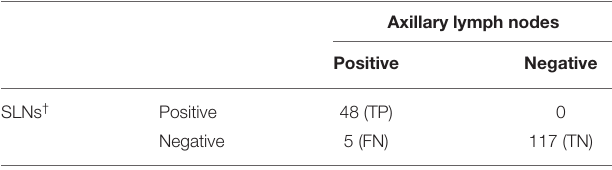
TABLE 2 | Pathologic status of sentinel and axillary lymph nodes in the patients with reSLNB. Axillary lymph nodes Positive Negative SLNs † Positive 48 (TP) 0 Negative 5 (FN) 117 (TN)